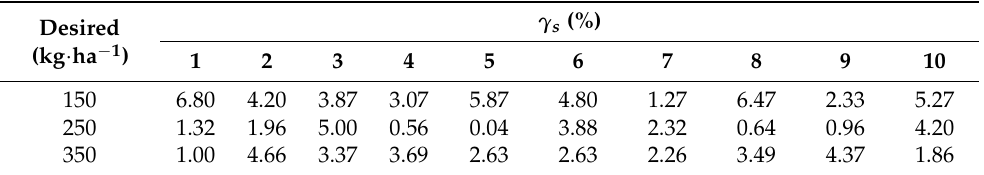
Table 4. Deviation of measured fertilization rate from desired values.